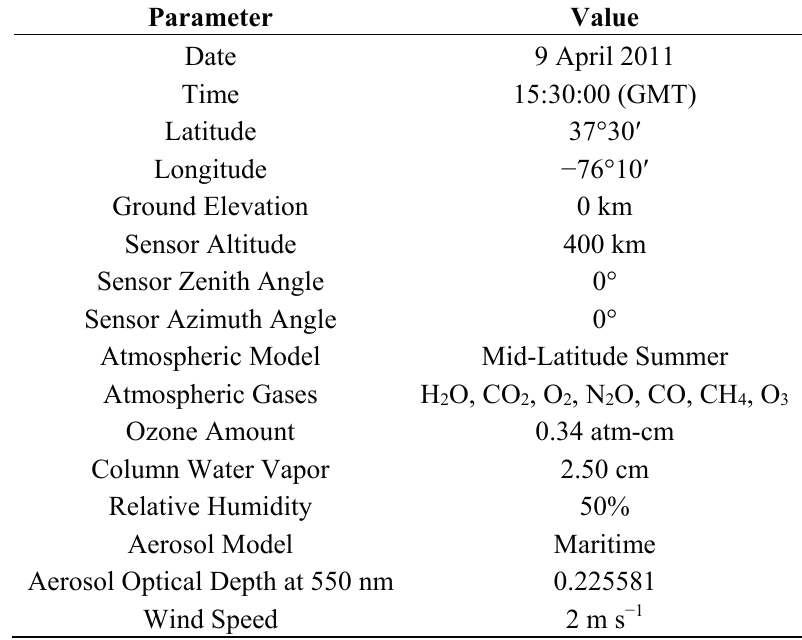
Table 2. Geographic, illumination, and atmospheric parameter values used for the upward propagation of the at-surface